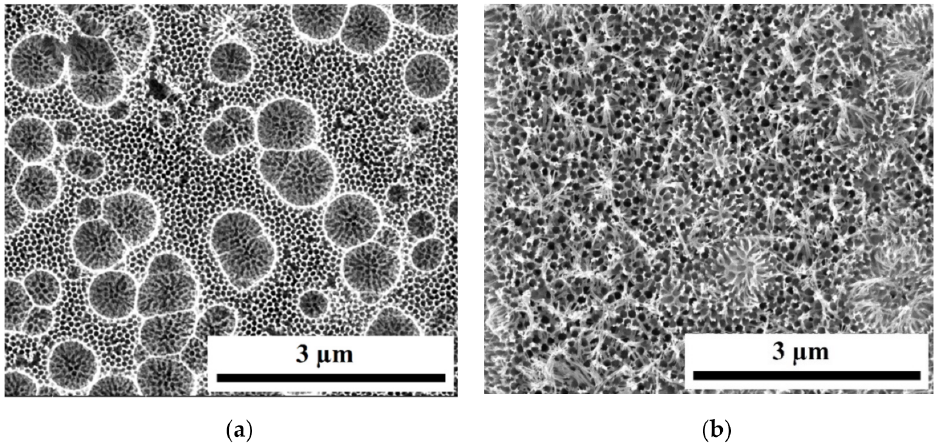
Figure 5. SEM micrographs of AAO samples prepared by 1 h ( a ) and 4 h ( b )